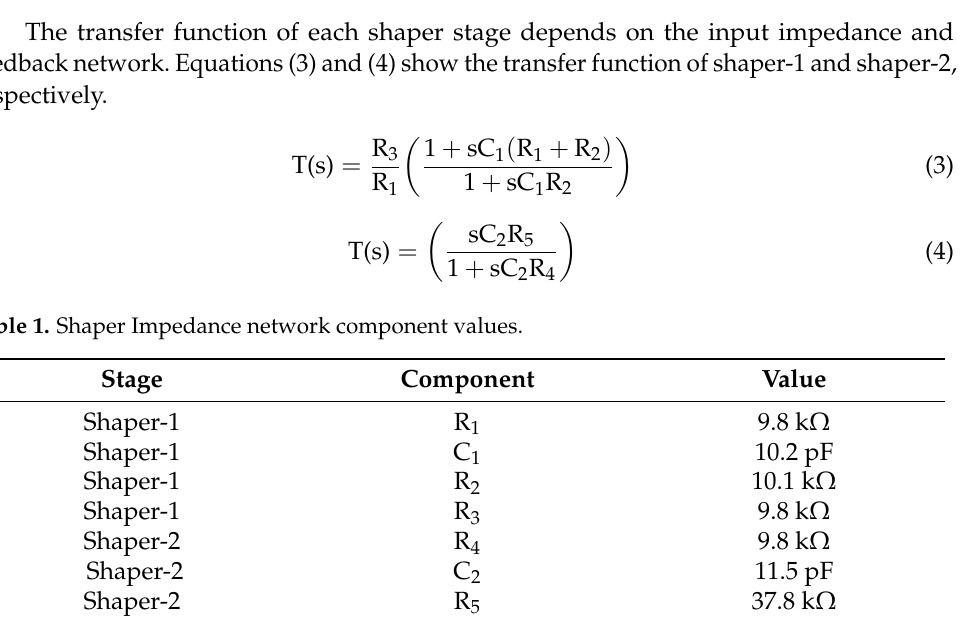
Figure 6. Analog signal-processing chain.